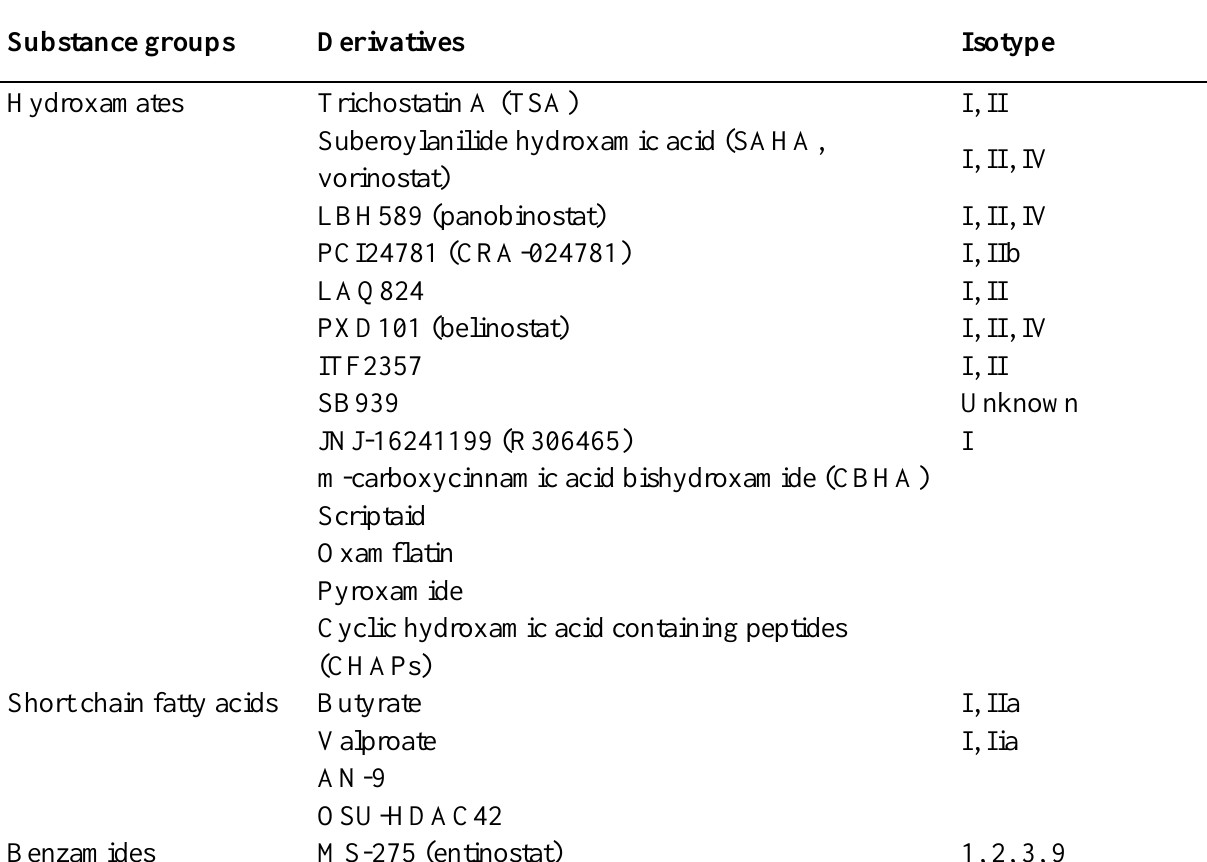
Table 1. Overview of frequently used histone deacetylase inhibitors that are available for clinical and research